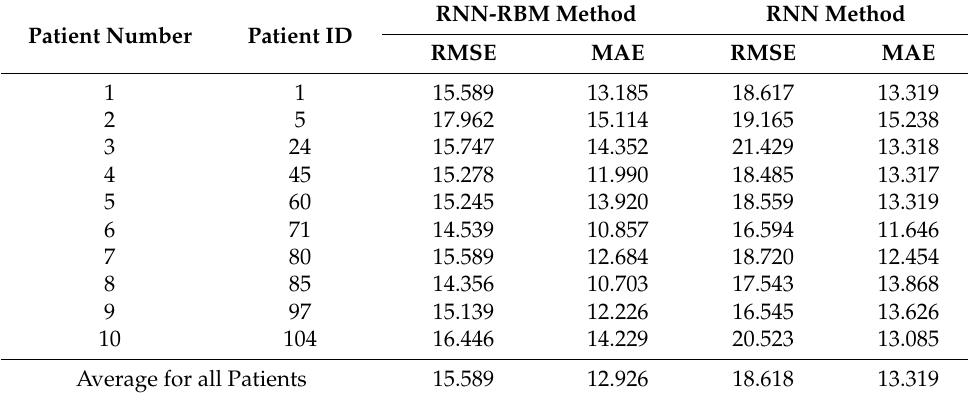
Table 4. The evaluation results.